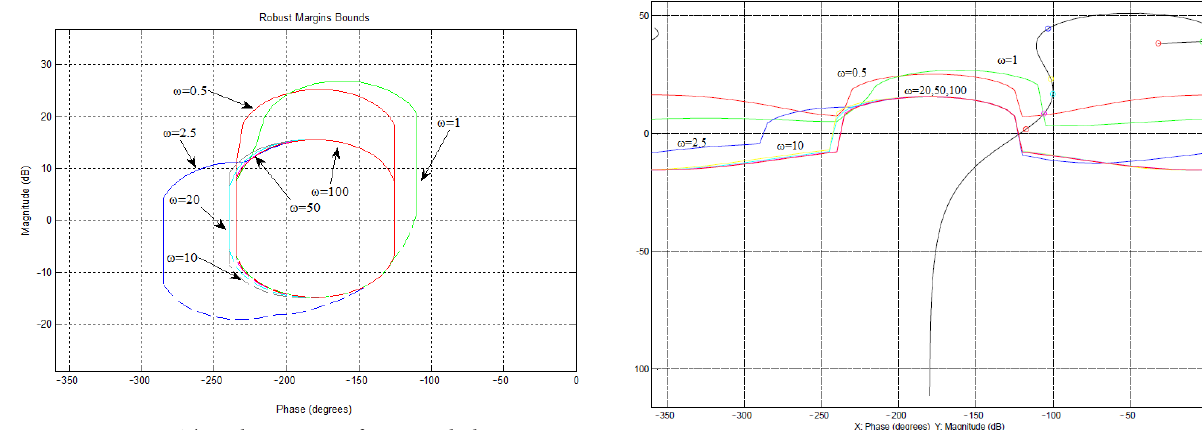
Figure 10. The robust margin for vertical plane